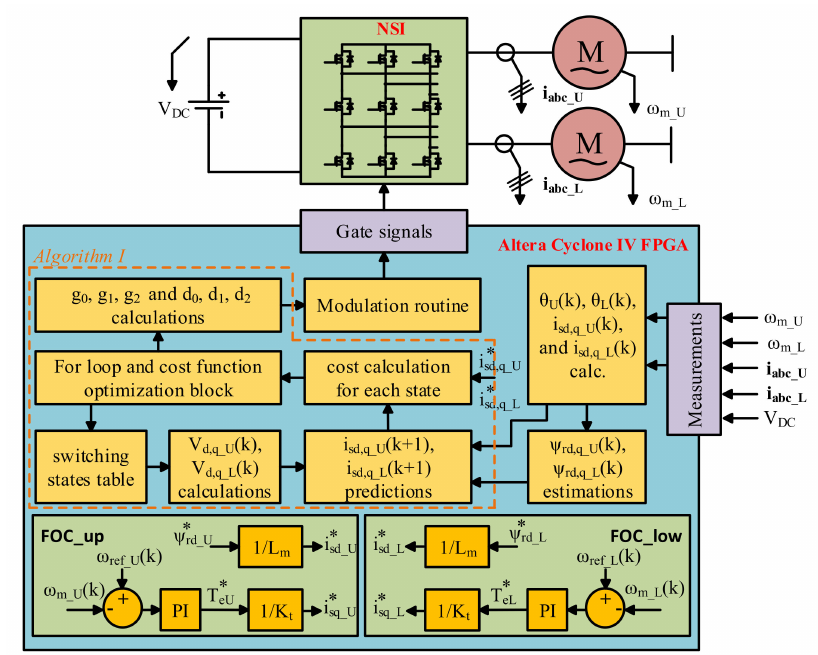
Figure 2. The scheme for proposed IFOC based M 2 PC of the NSI drive system. An FPGA (Altera Cyclone IV) is used to accomplish the proposed